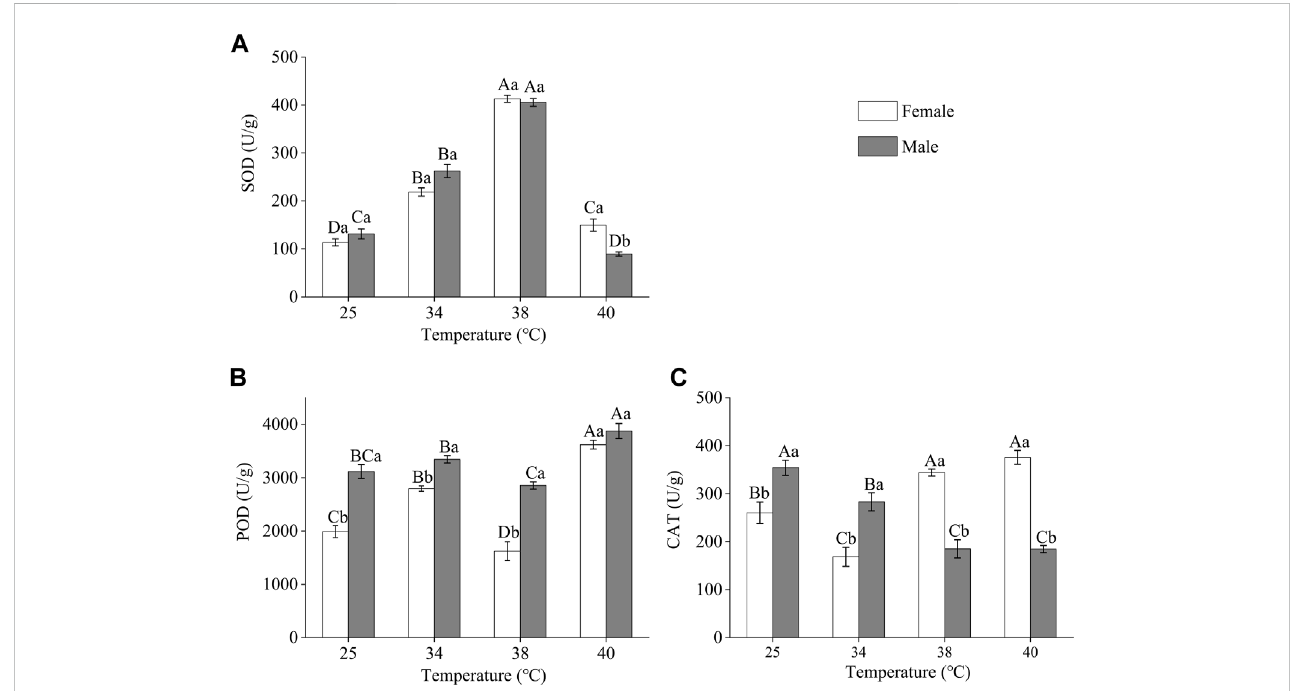
FIGURE 2 Antioxidant enzyme activities in Z. tau adults exposed to different high-temperature treatments for 12 h. Data are presented as the mean ± SE. Different lowercase letters above bars represent a signi fi cant difference in the antioxidant enzyme activity between females and males at the same temperature. In contrast,differentuppercaselettersabovebarsindicateasigni fi cantdifferenceintheantioxidantenzymeactivitiesoffemales/malesatdifferenttemperatures ( p < 0.05) (A) SOD (B) POD, and (C)